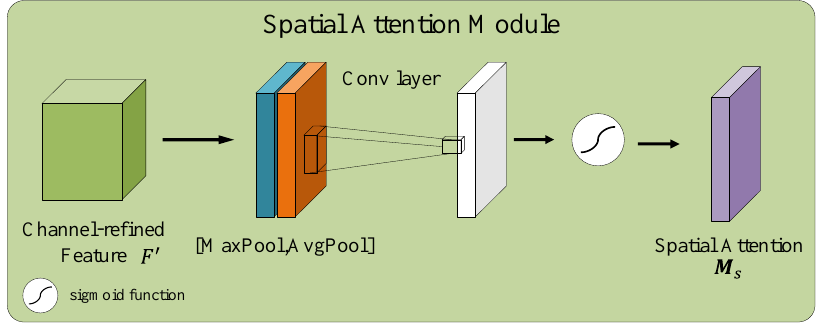
Figure 4. Spatial attention module.